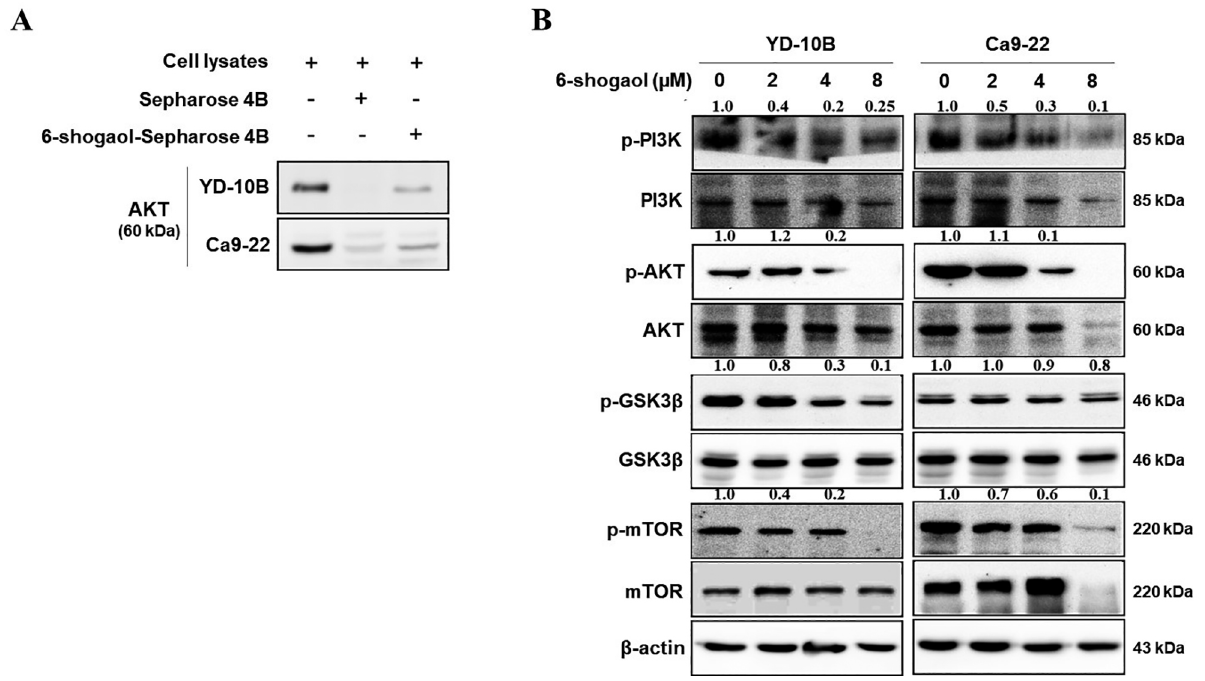
Figure 4- Effects of 6-shogaol on the PI3K/AKT signaling pathway in OSCC cells. (A) Pull-down assay showing 6-shogaol bound to AKT. (B) Western blot analysis of the expressions of proteins related to the PI3K/AKT/mTOR signaling pathway in OSCC cells treated by 6-shogaol